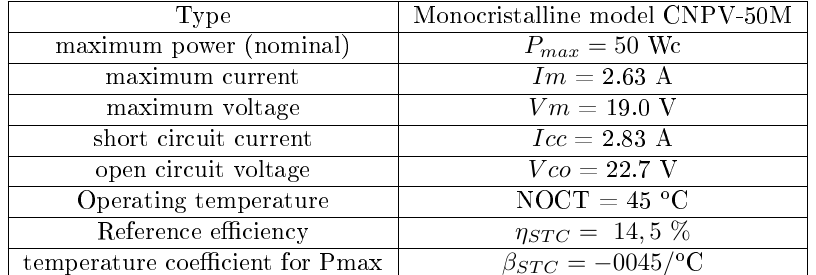
Table 3. Below gives the characteristics of our module.